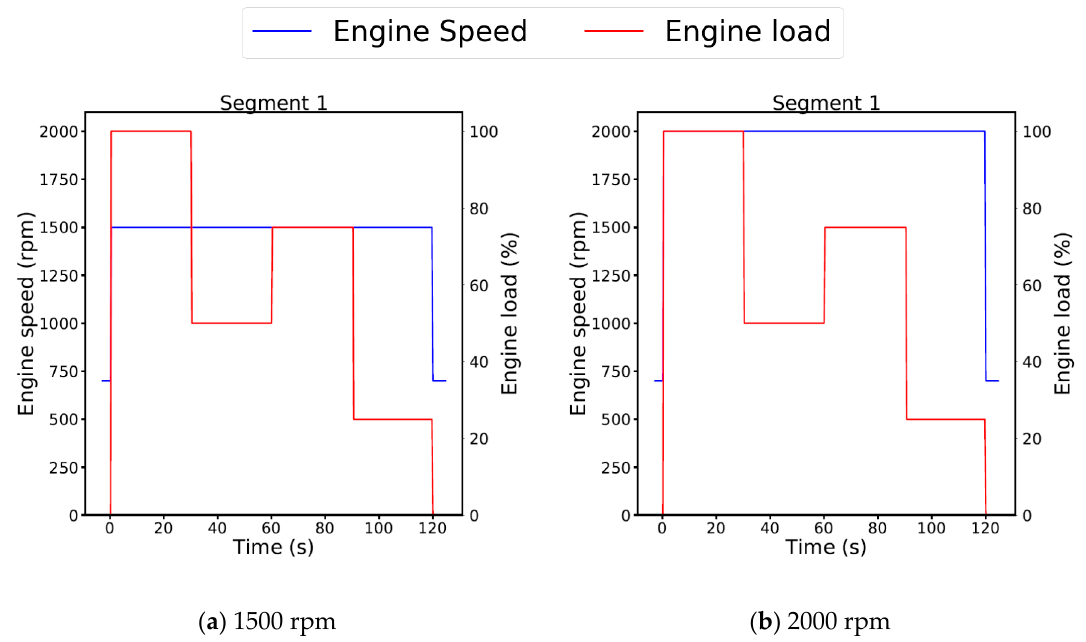
Figure 1. Engine speed and load changes during one (of eight) engine run segments of the custom designed drive cycle at ( a ) 1500 rpm and ( b ) 2000 rpm. The blue line corresponds to the engine speed and the red line corresponds to the engine load.